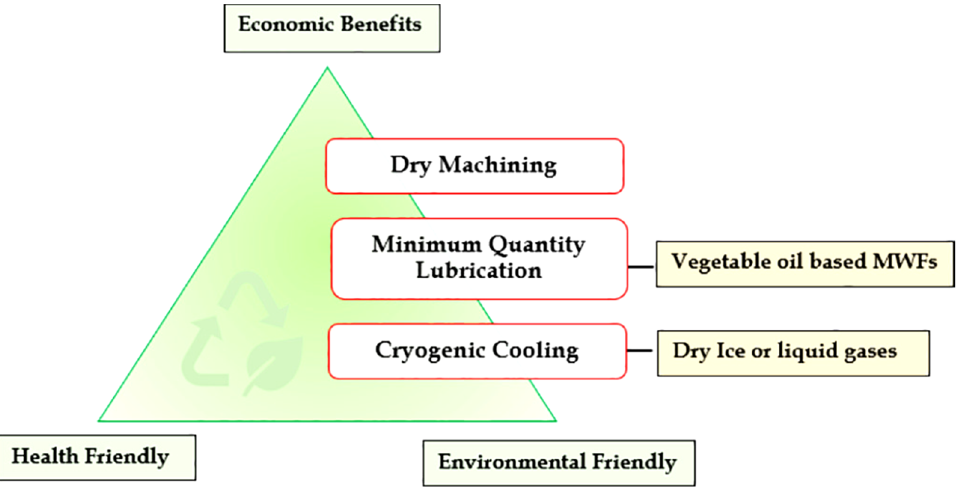
Figure 1. The opportunities for performing sustainable machining.